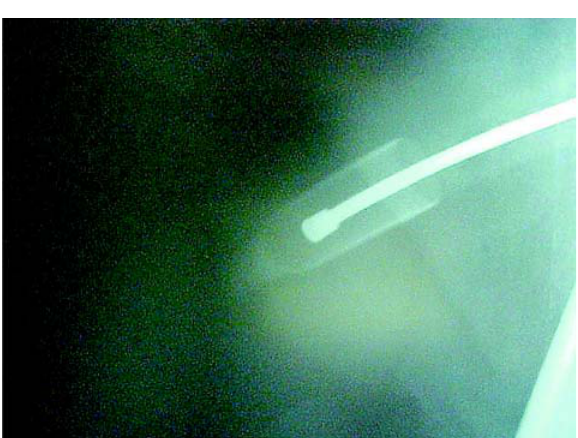
Figure 1 – Rx showing a single prosthesis implanted in an inverted fashion.